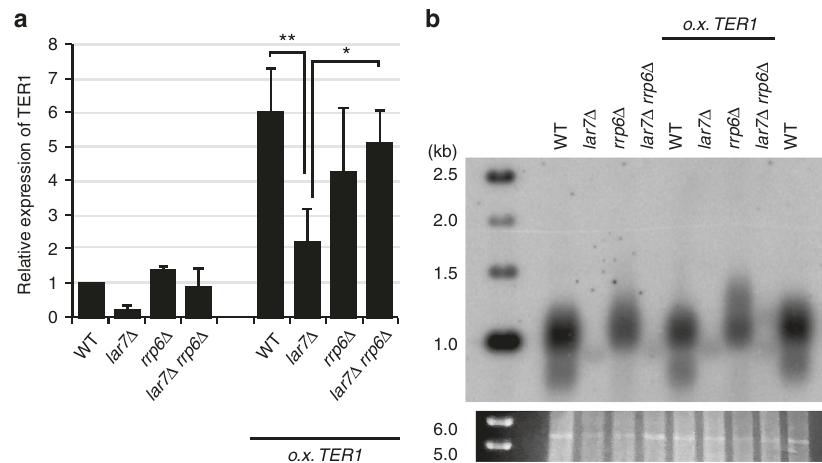
Fig. 4 lar7 Δ causes exosomal degradation of TER1. a Expression of TER1 mRNA quanti fi ed using RT-qPCR and normalised to actin. Expression is shown relative to wild-type cells without the ter1 overexpression promoter. rrp6 Δ rescues the reduced expression seen in lar7 Δ cells. Data represented as a mean of four independent experiments. Error bars show standard deviation. Signi fi cantly less TER1 was detected in lar7 Δ vs WT ter1 overexpression promoter cells ( p = 0.0063) and lar7 Δ vs. lar7 Δ rrp6 Δ ter1 overexpression promoter ( p = 0.0242, unpaired t test * at p > 0.05 and ** at p < 0.01). b Telomere southern blot. The rescued expression of TER1 in lar7 Δ rrp6 Δ cells shown in a did not rescue short telomere phenotype (lanes 4 and